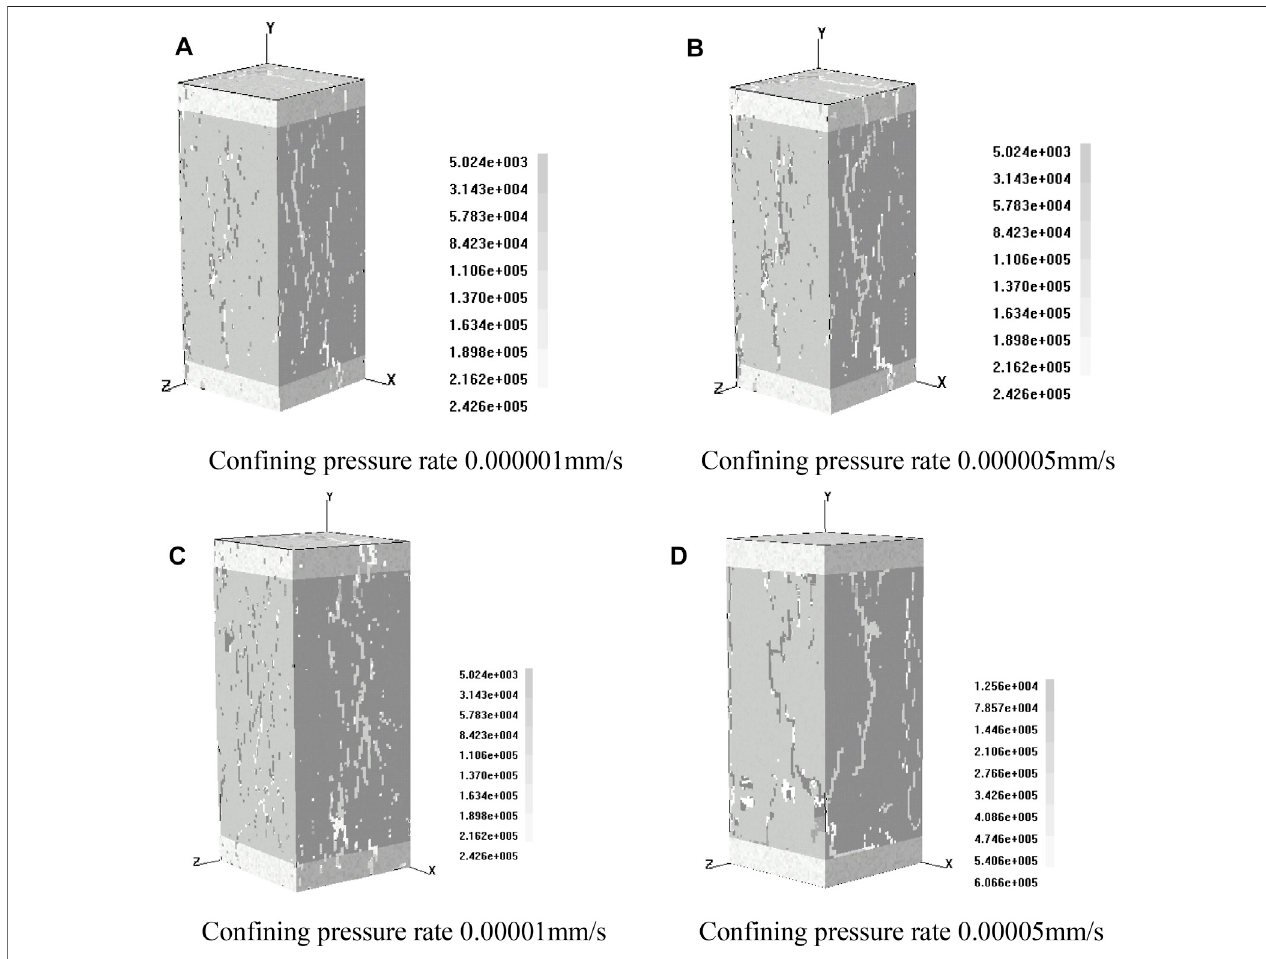
FIGURE 8 | Final failure modes of rock specimens under different con fi ning pressures. (A) is the fi nal failure result of the model at the con fi ning pressure rate of 0.000001 mm/s. (B) is the fi nal failure result of the model at the con fi ning pressure rate of 0.000005 mm/s. (C) is the fi nal failure result of the model at the con fi ning pressure rate of 0.00001 mm/s. (D) is the fi nal failure result of the model at the con fi ning pressure rate of 0.00005 mm/s.